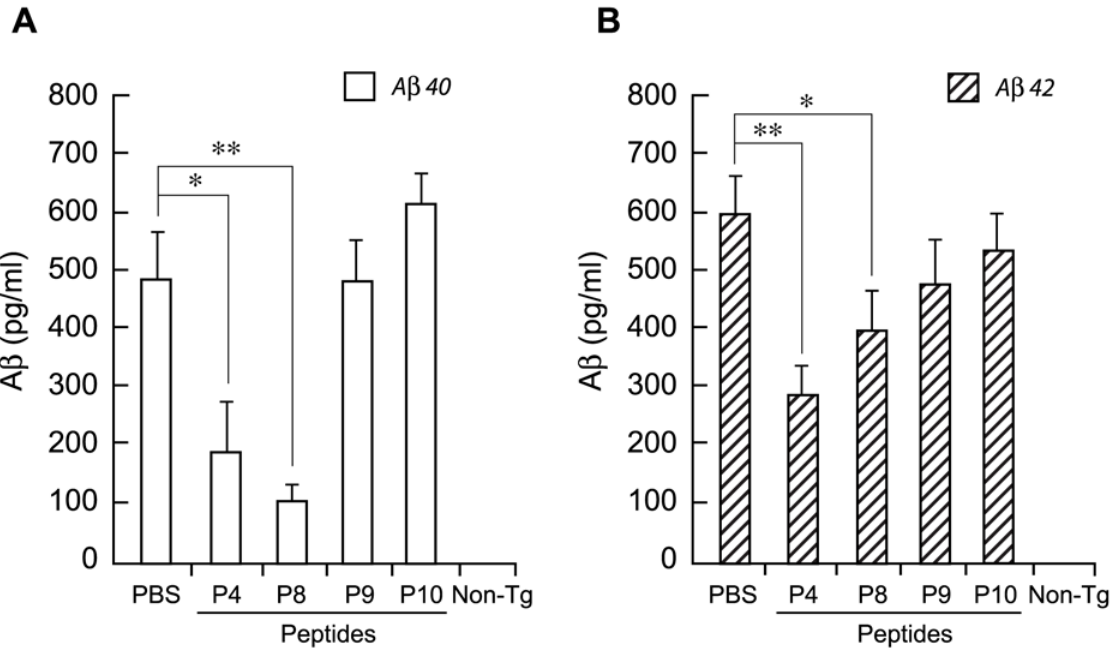
Fig 4. ELISA Analysis Of A β 40 And 42 In mThy1-hAPP Mouse Brains Treated With Peptides P4 To P10. Extracts of neocortex from peptide-treated Tg mice were subjected to A β 40- (A) and A β 42-specific (B) ELISA analysis. Three to six samples were analyzed per mouse and the average of individual measurements was used to calculate group means. Values represent group means ± s.e.m. * , p < 0.05; ** , p < 0.005 versus PBS, by ANOVA.